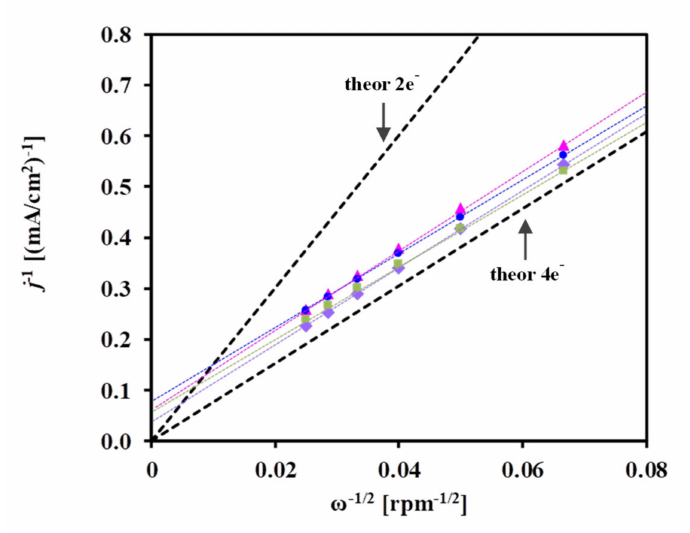
Figure 7. Koutecky–Levich representation of ORR measurements obtained at 300 mV vs. RHE on the ( (cid:4) ) Pt/75BP, ( (cid:78) ) Pt/75F-BP, ( • ) Pt/75V, and ( (cid:7) ) Pt/C